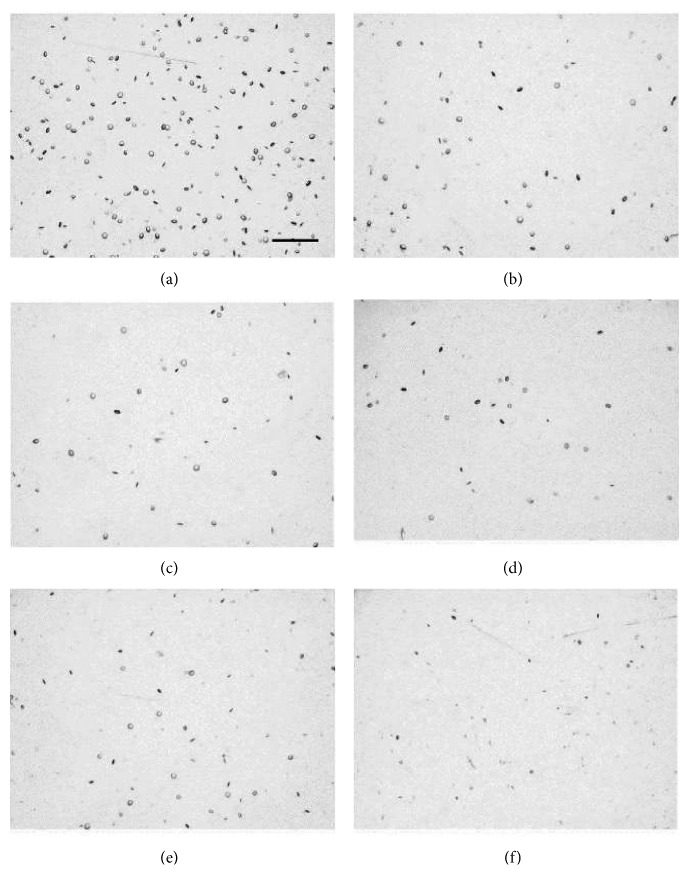
Images of IOL #1 (a), #2 (b), #3 (c), #4 (d), #5 (e), and #6 (f) at 100x magnification. Scale bar, 500 μm.